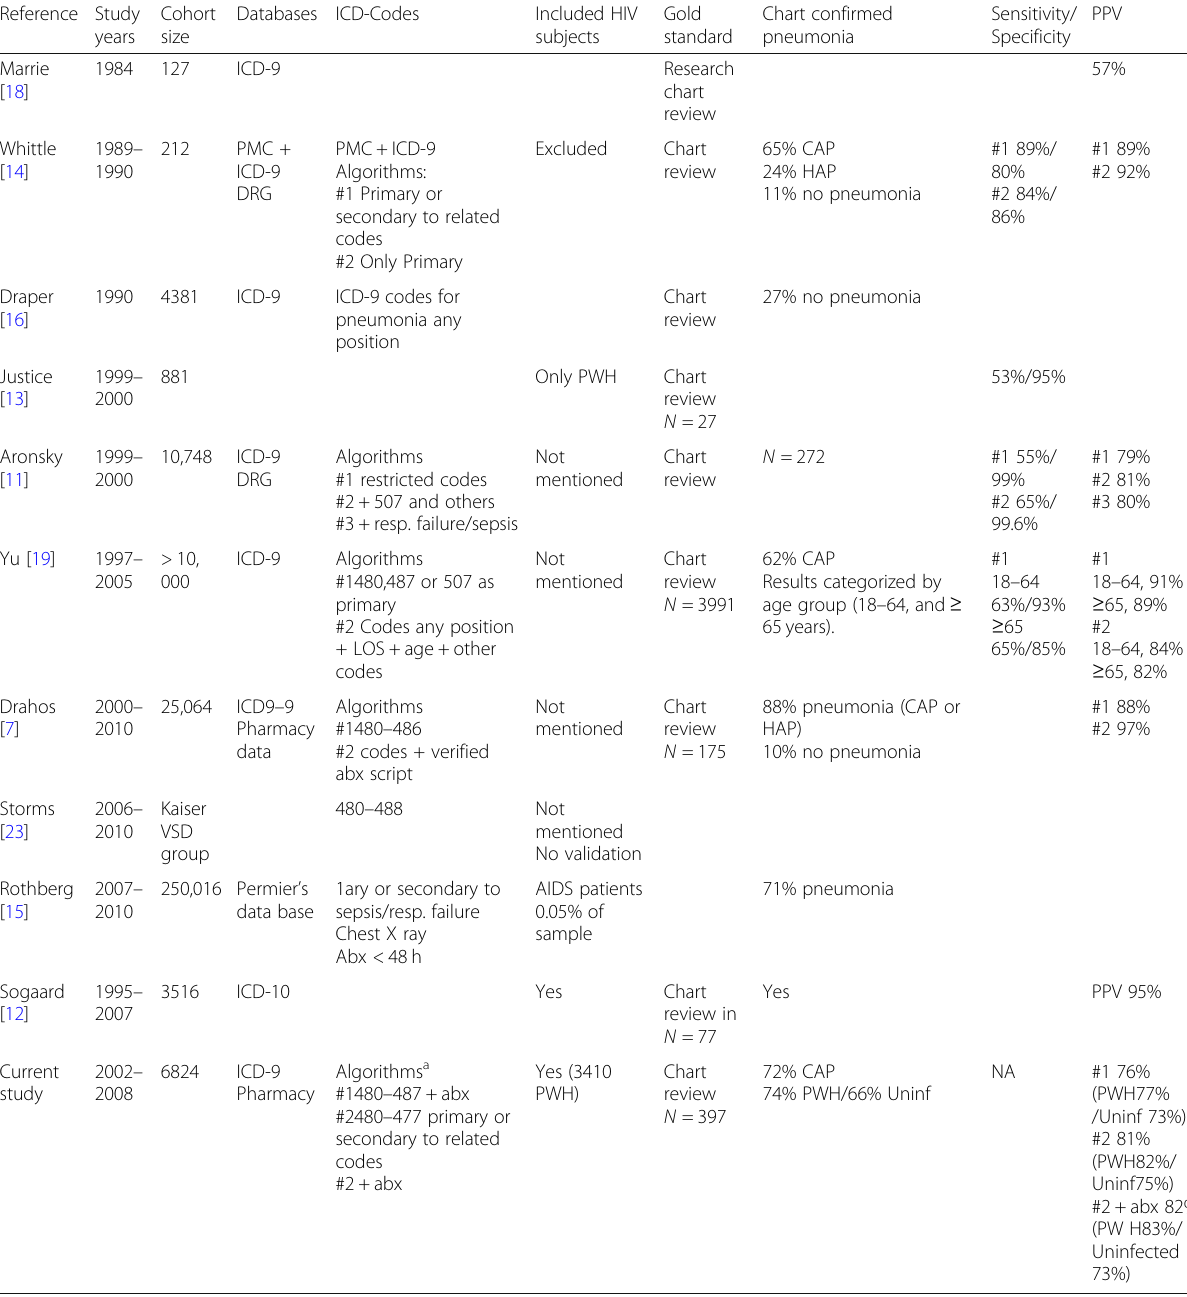
Table 4 Positive predictive value (PPV) for pneumonia identified by ICD codes Reference Study